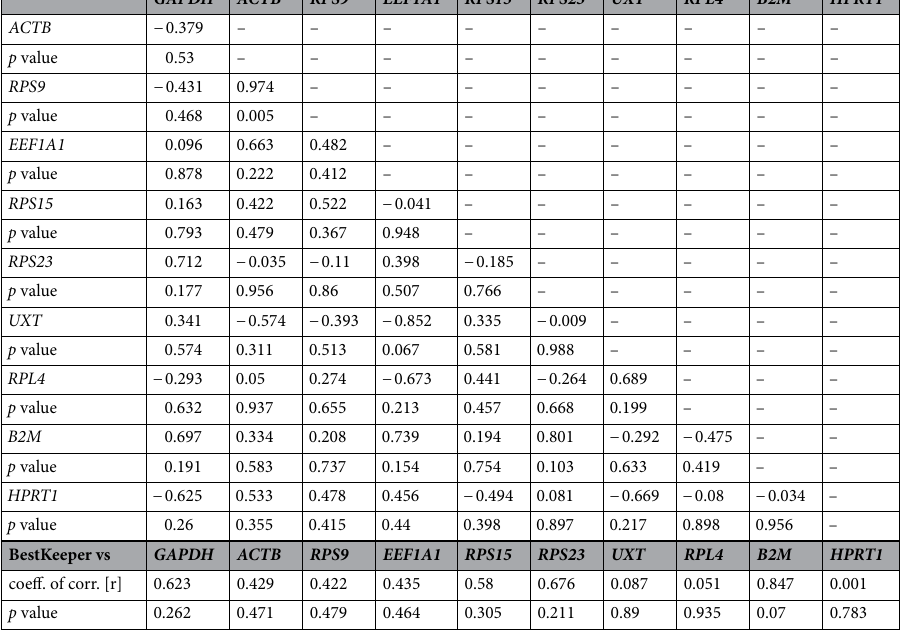
Table 11. Analysis of repeated pair-wise correlation amongst genes in CHG with BestKeeper index.